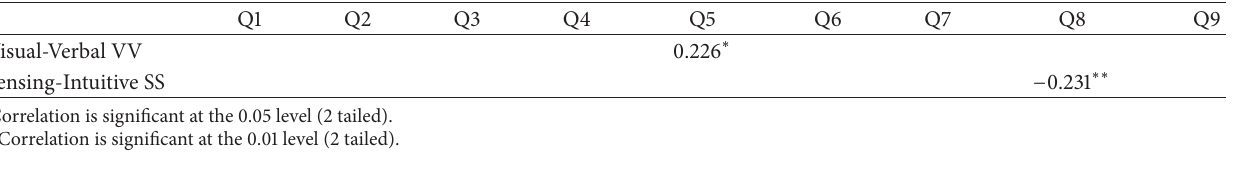
Table 8: Correlation between learning style (perception and input dimensions) and cognitive alert style.